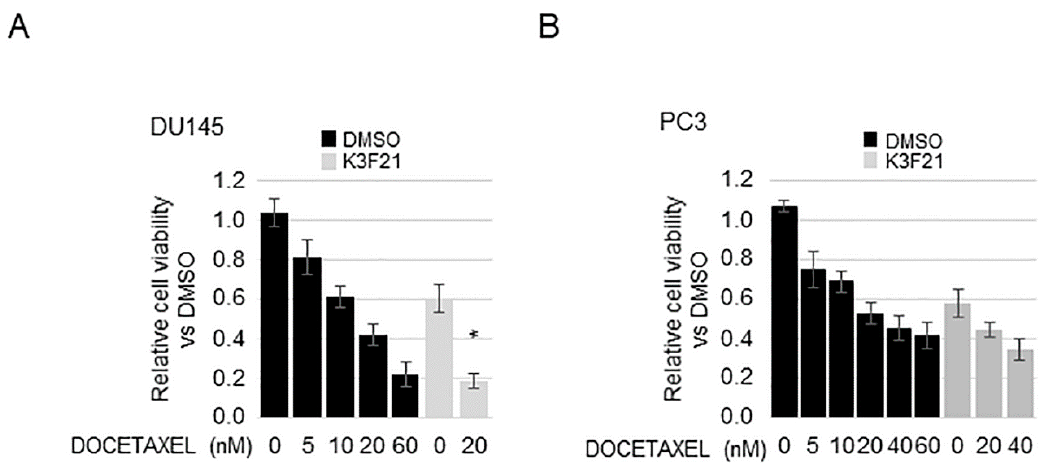
Figure 9. Combinatorial effect of K3F21 with docetaxel on PCa cells viability. The effect of docetaxel or docetaxel/K3F21 co-administration determined by MTT assay in DU145 ( A ) and PC3 ( B ) is indicated relatively to DMSO treatment, arbitrarily set at 1. * indicates synergism (CI < 1).